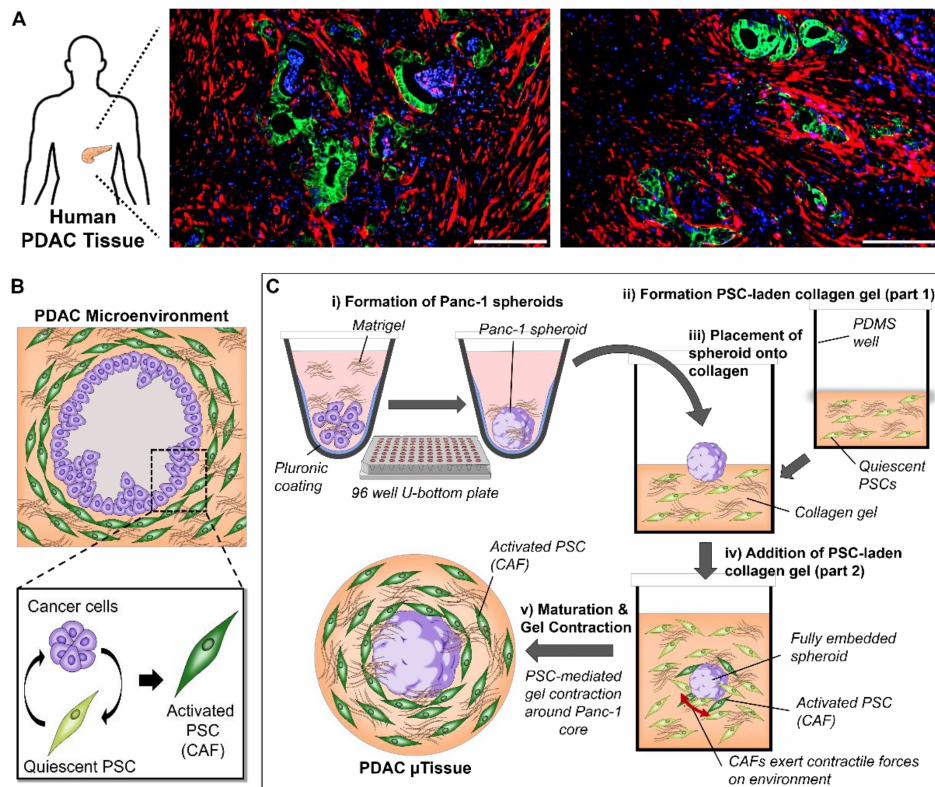
Figure 1. Cellular arrangement of PDAC and generation of PDAC µ tissues. ( A ) Immunostaining for α SMA (red), CK19 (green) and nuclei (blue) in human PDAC tissues (scale bar = 200 µ m). ( B ) Schematic representation of the cellular arrangement of pancreatic cancer cells and pancreatic stellate cells (PSCs) highlighting the crosstalk and subsequent activation of PSCs. ( C ) Generation of PDAC µ tissues starting with (i) the generation of Panc-1 cancer cell spheroids based on the culture in a pluronic-coated 96 well U-bottom plate, (ii) the formation of a PSC-laden collagen gel and (iii) placement of Panc-1 spheroid onto the formed collagen layer before (iv) embedding by addition of a second half of the PSC-laden collagen gel. (v) Maturation of the µ tissues including the PSC-mediated gel